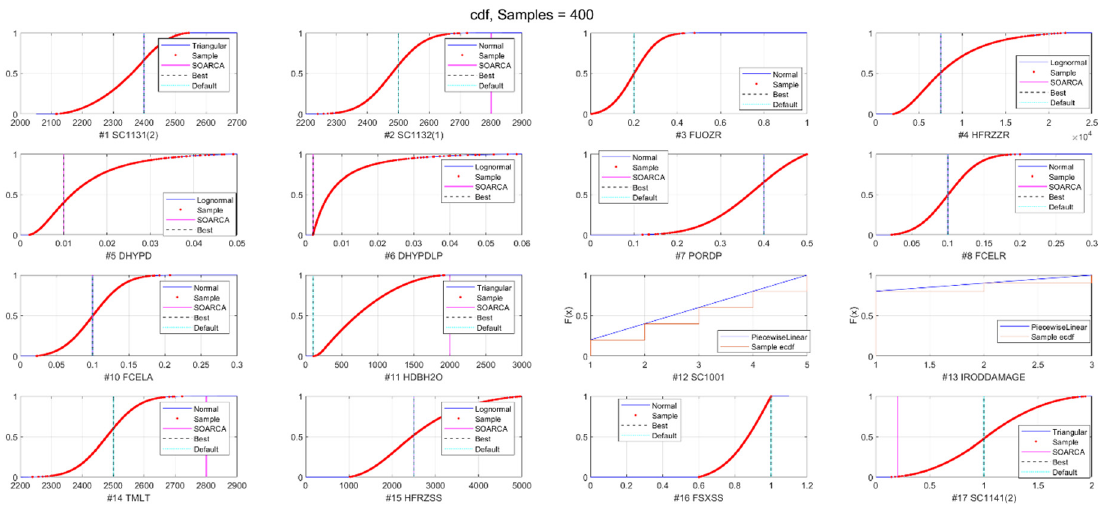
Figure A1. CDF functions and samples for PWR peaked profile model. For the PWR FPT-like profile, the same distributions were applied but with a different sampling seed.